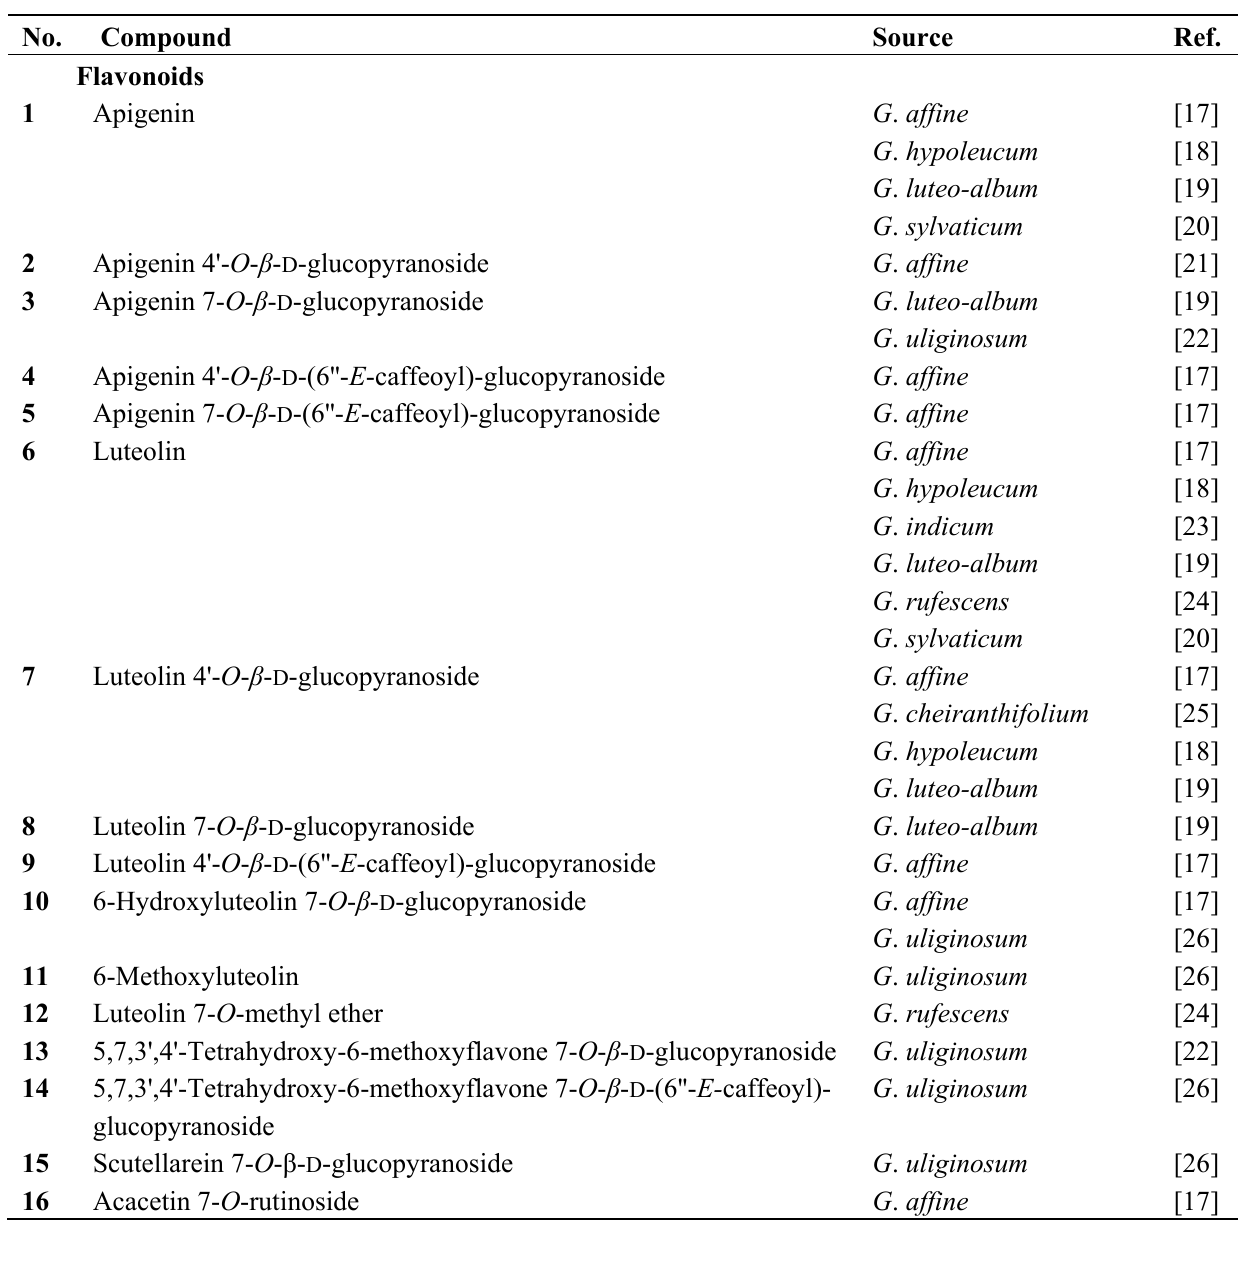
Table 1. Flavonoids, sesquiterpenes, diterpenes, triterpenes, phytosterols, anthraquinones, caffeoylquinic acid derivatives, and other compounds from the genus Gnaphalium